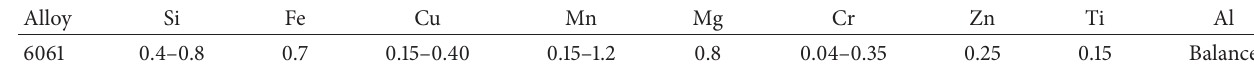
Table 1: Composition of 6061 aluminum alloy.